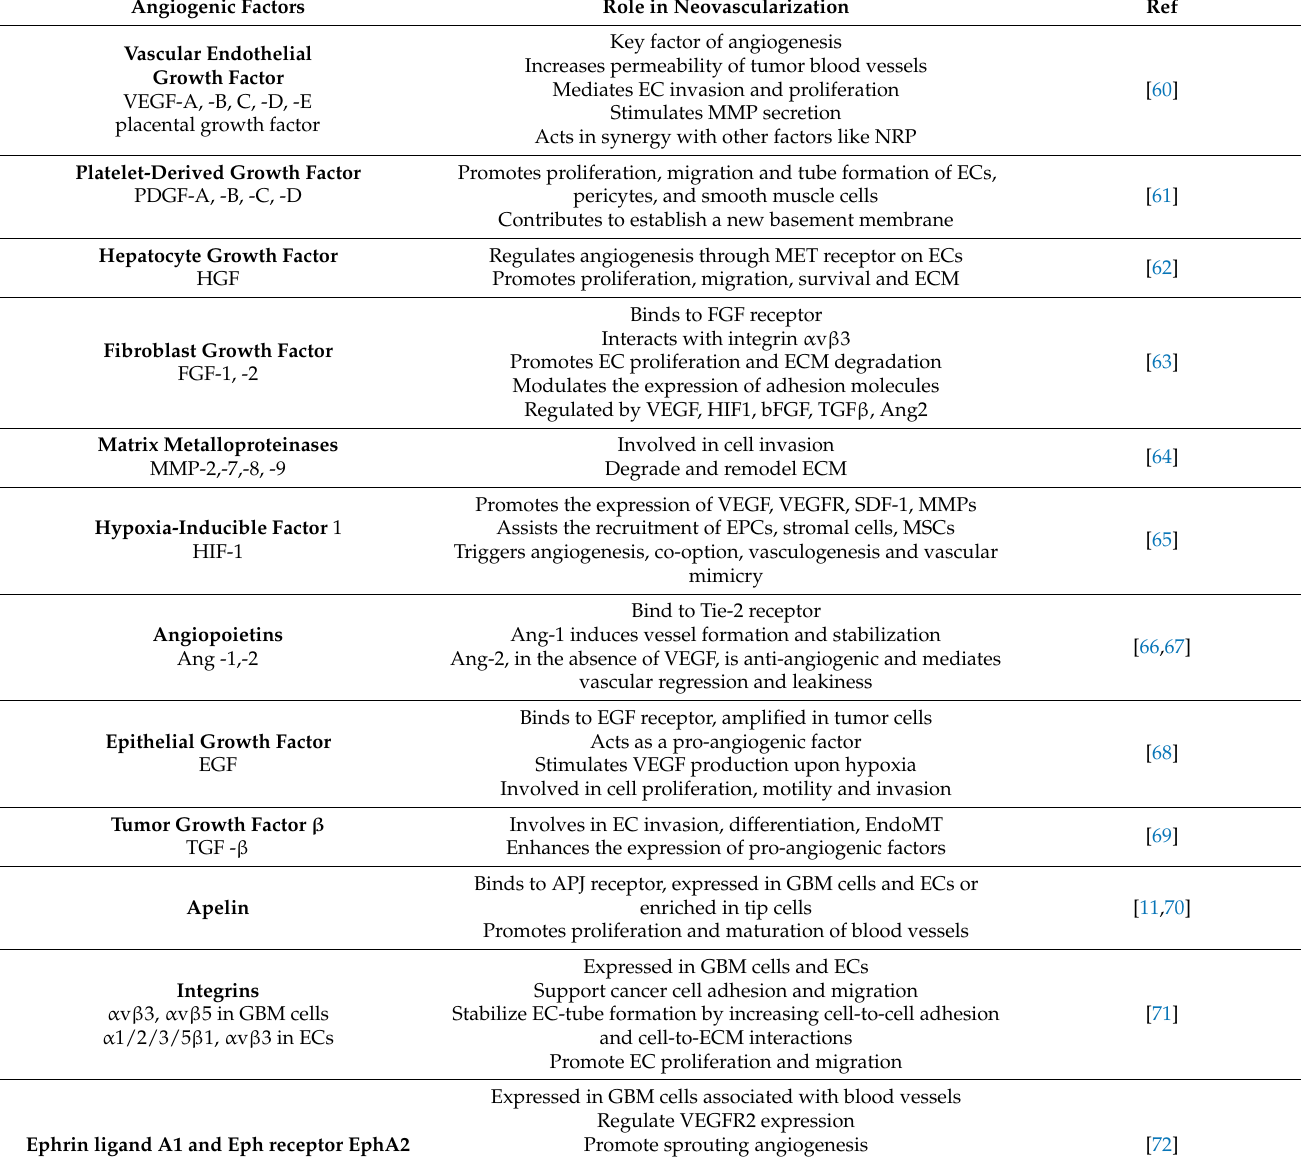
Table 1. List of the key pro- and anti-angiogenic factors involved in GBM vessel